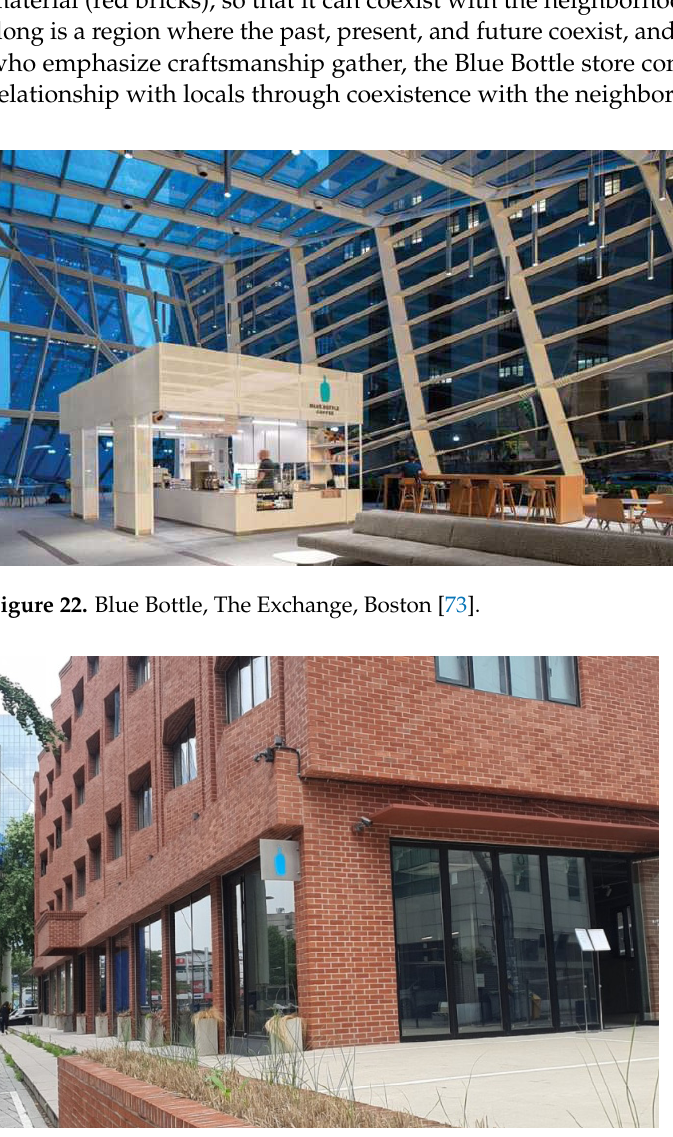
Figure 23. Blue Bottle in Seongsu.